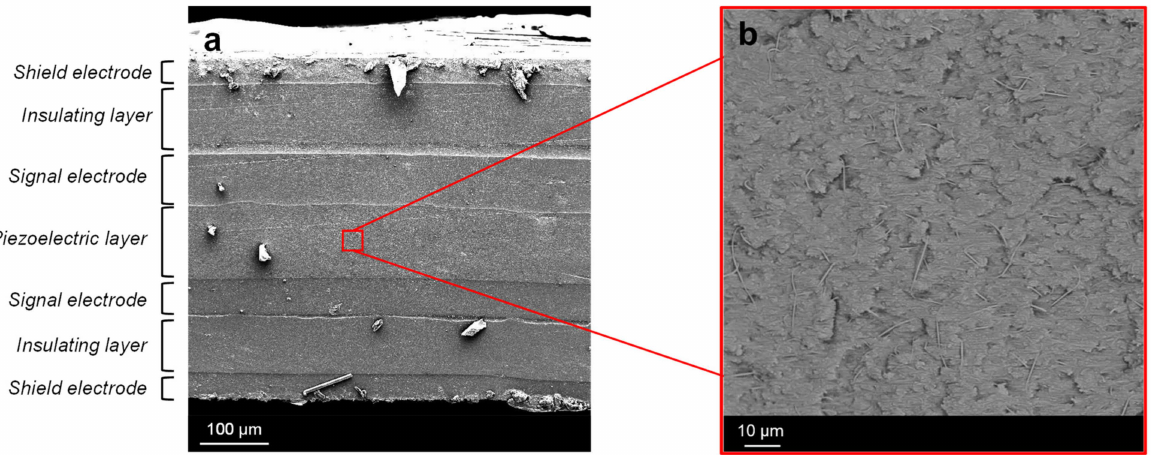
Figure 14. ( a ) SEM micrograph analyses of the piezoelectric sensor cross section ( b ) and of the nanofibrous layer embedded in the hosting